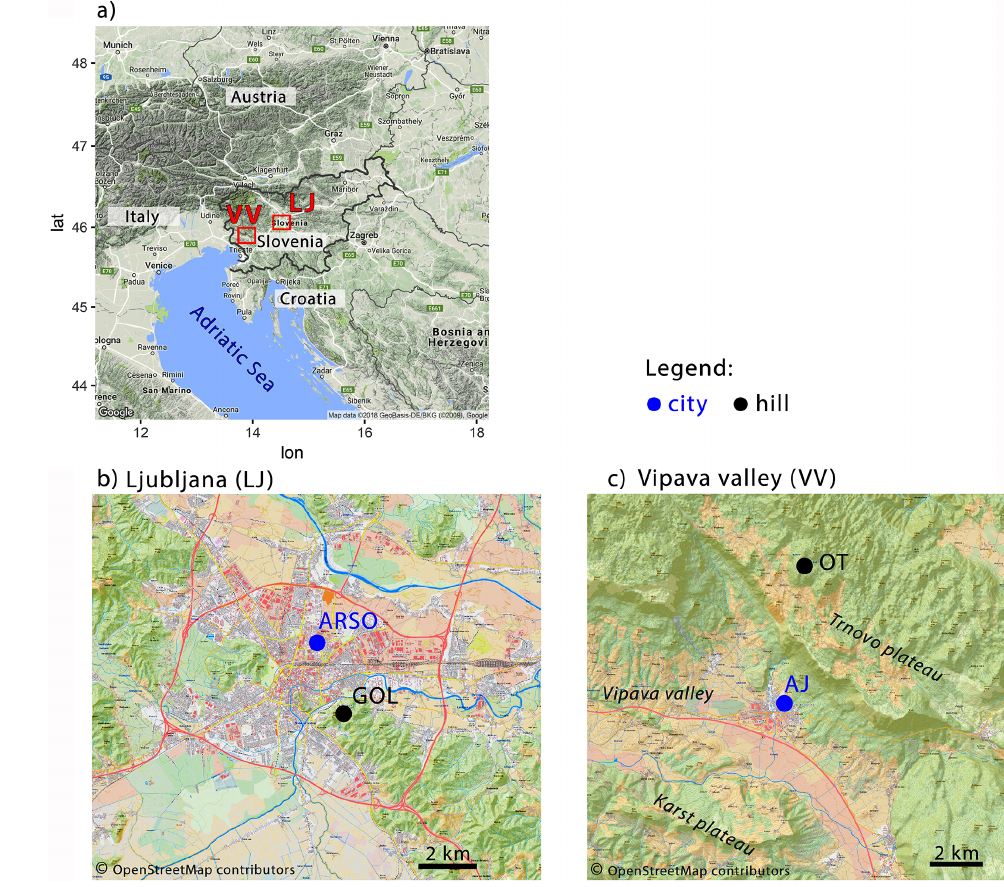
Figure 1. Map of Slovenia (a) with marked areas of measurement sites Ljubljana (LJ) and Vipava valley (VV). (b) The city of Ljubljana with urban background (ARSO) and hill (Golovec – GOL) measurement sites. (c) Area of the Vipava valley with urban background (Ajdovšˇcina – AJ) and hill (Otlica – OT) measurement sites (Source: map data © 2018 GeoBasis-DE/BKG (© 2009) Google and